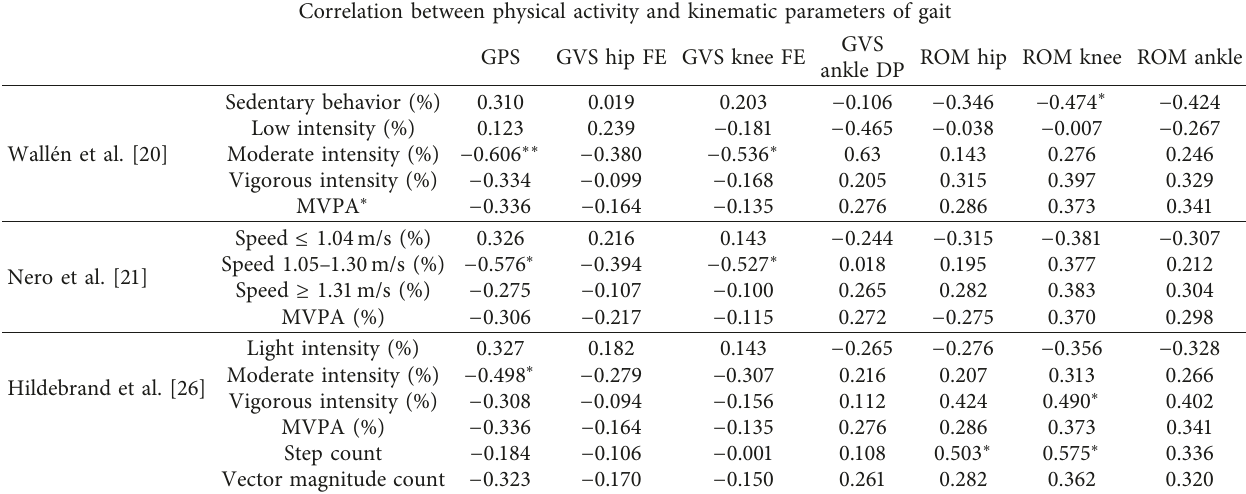
Table 6: Correlation analysis between physical activity intensity and kinematic parameters of gait. Correlation between physical activity and kinematic parameters of